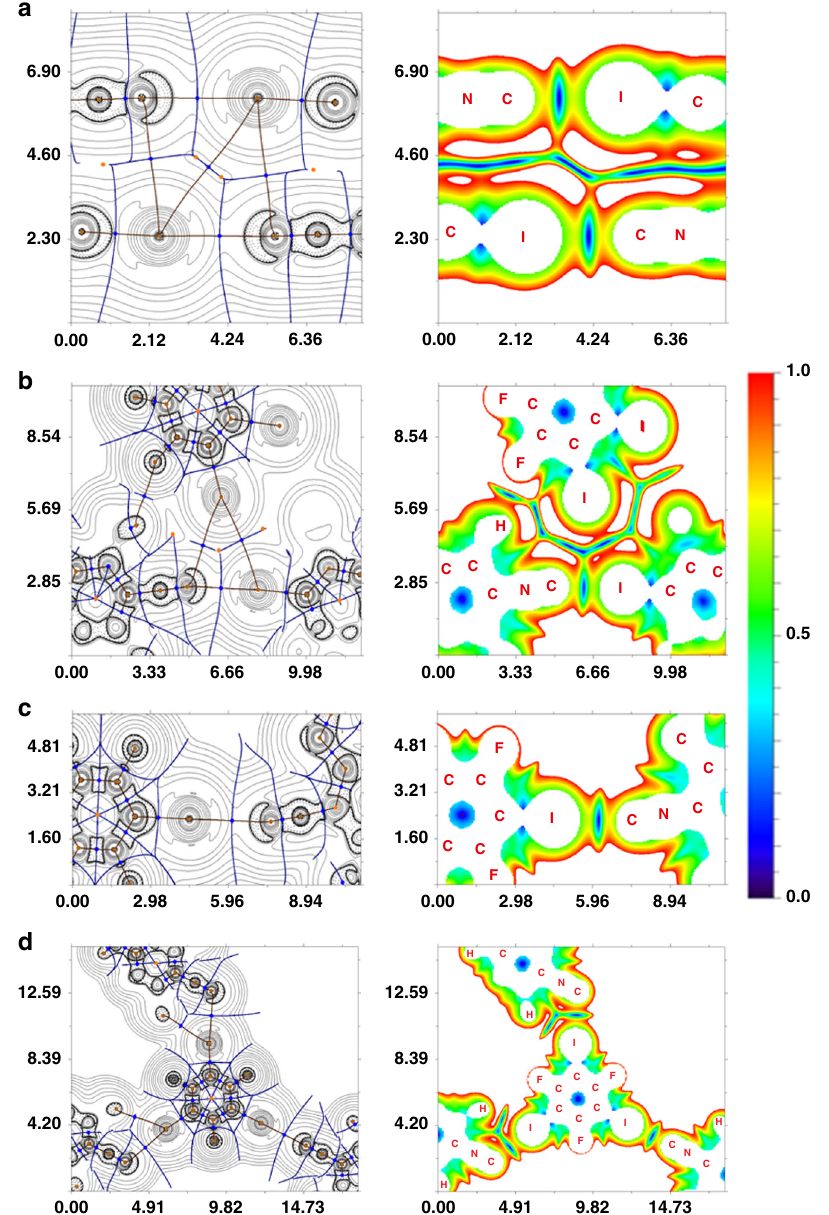
Fig. 3 Visualization of the QTAIM analysis results for the XB adducts with CNMes. Contour line diagrams of the Laplacian distribution ∇ 2 ρ (r), bond paths and selected zero- fl ux surfaces (left) and RDG isosurfaces (right) referring to I···C and I···I noncovalent interactions in a (CNMes) (cid:129) IPFB, b (CNMes) (cid:129) 1,2-FIB, c (CNMes) (cid:129) 1,4-FIB, and d (CNMes) (cid:129) 1,3,5-FIB. Bond critical points (3, – 1) are shown in blue, nuclear critical points (3, – 3) — in pale brown, ring 2 2 critical points (3, + 1) — in orange. Length units — Å, RDG isosurface values are given in